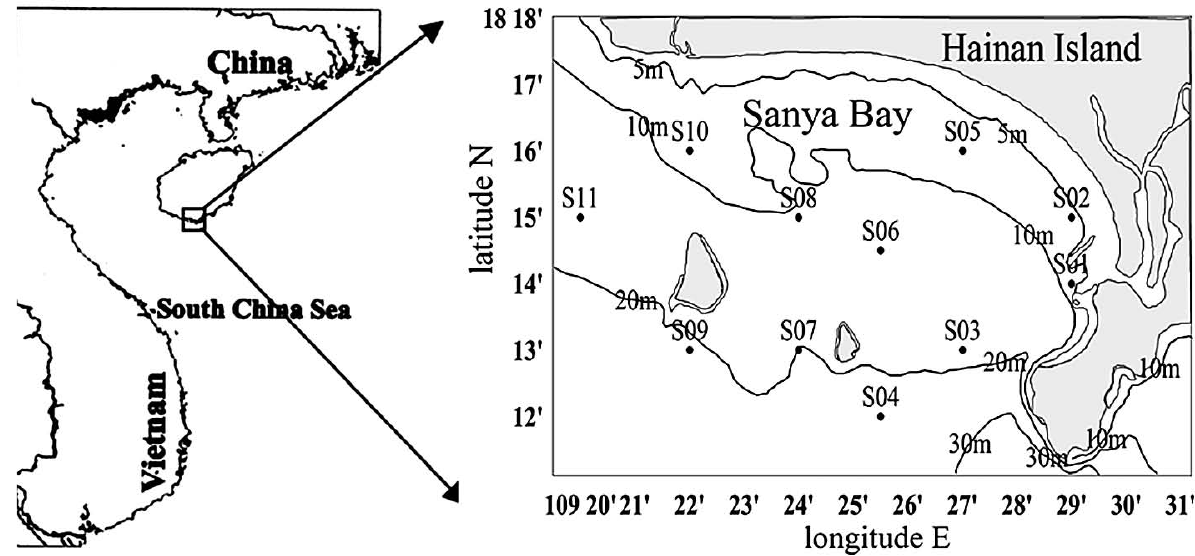
Fig . 1. – Location of 11 sampling stations in Sanya Bay (Dong et al .,